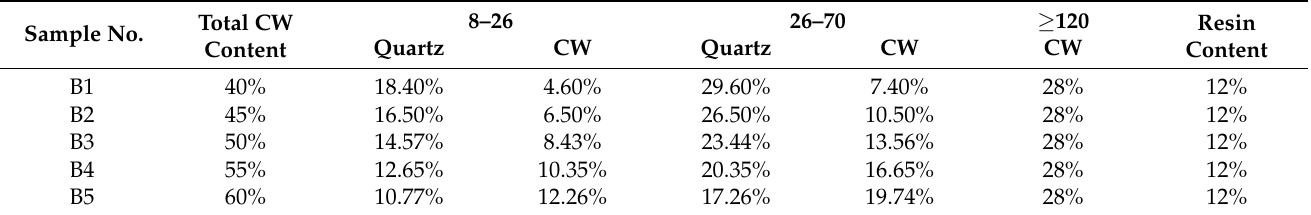
Table 2. Batching of Group B samples with ceramic waste particles instead of quartz sand of different sizes (in mass